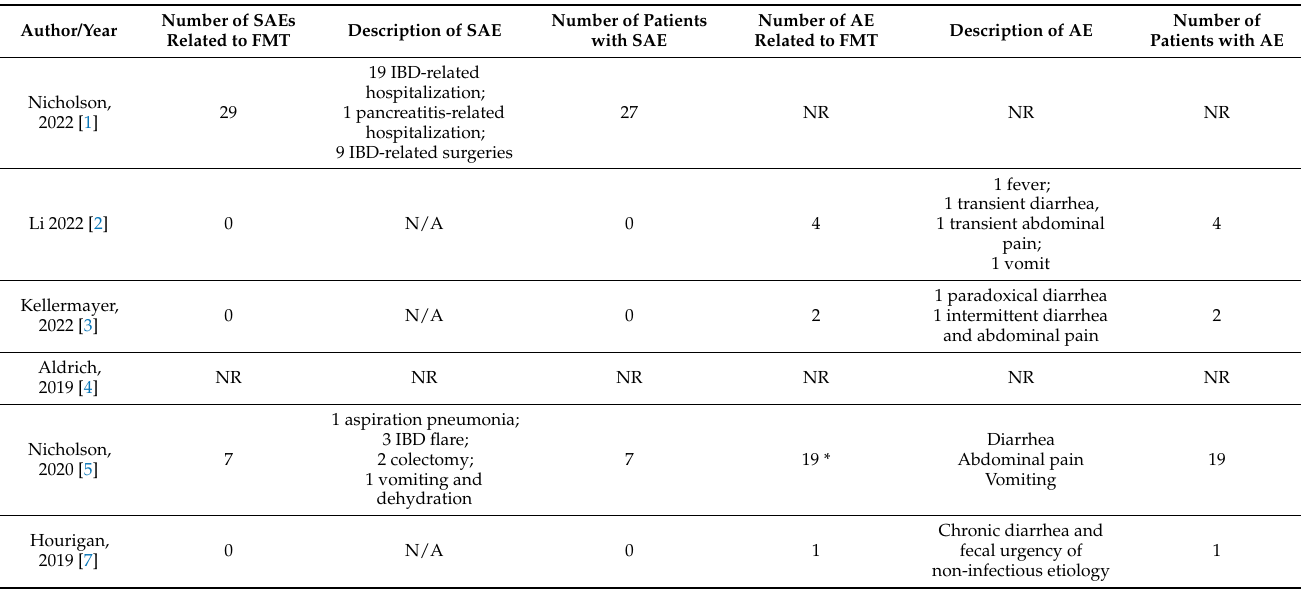
Table 7. Serious adverse events and adverse